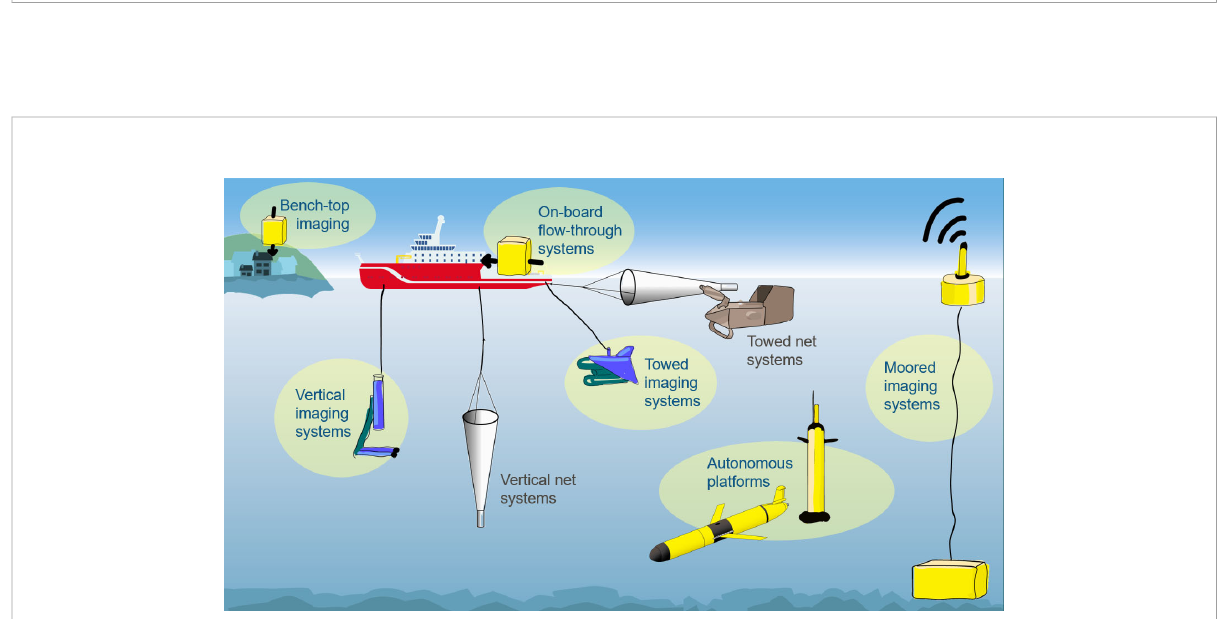
FIGURE 9 Future zooplankton sampling network. The biggest leverage can be made when both physical sampling, such as vertical and towed net systems, and imaging (highlighted by yellow backgrounds) are used strategically in conjunction. Imaging systems fi tted to autonomous and moored platforms allow global coverage with reduced reliance on